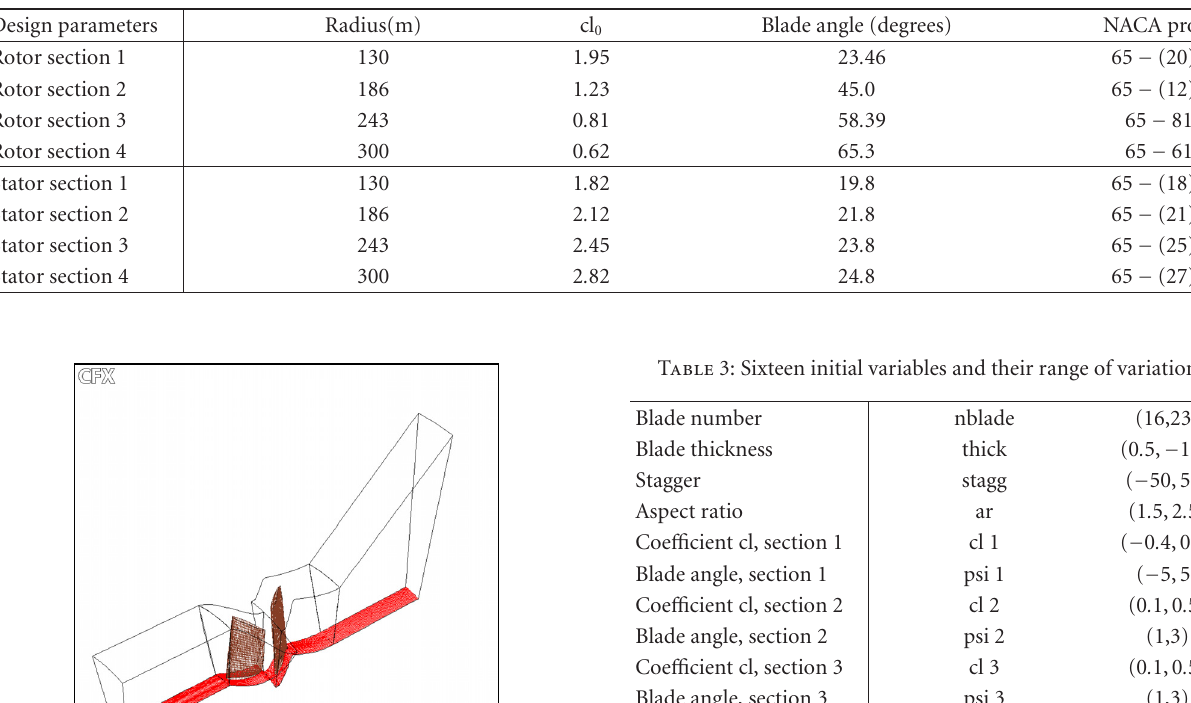
Table 2: Features of the rotor and stator blade sections.